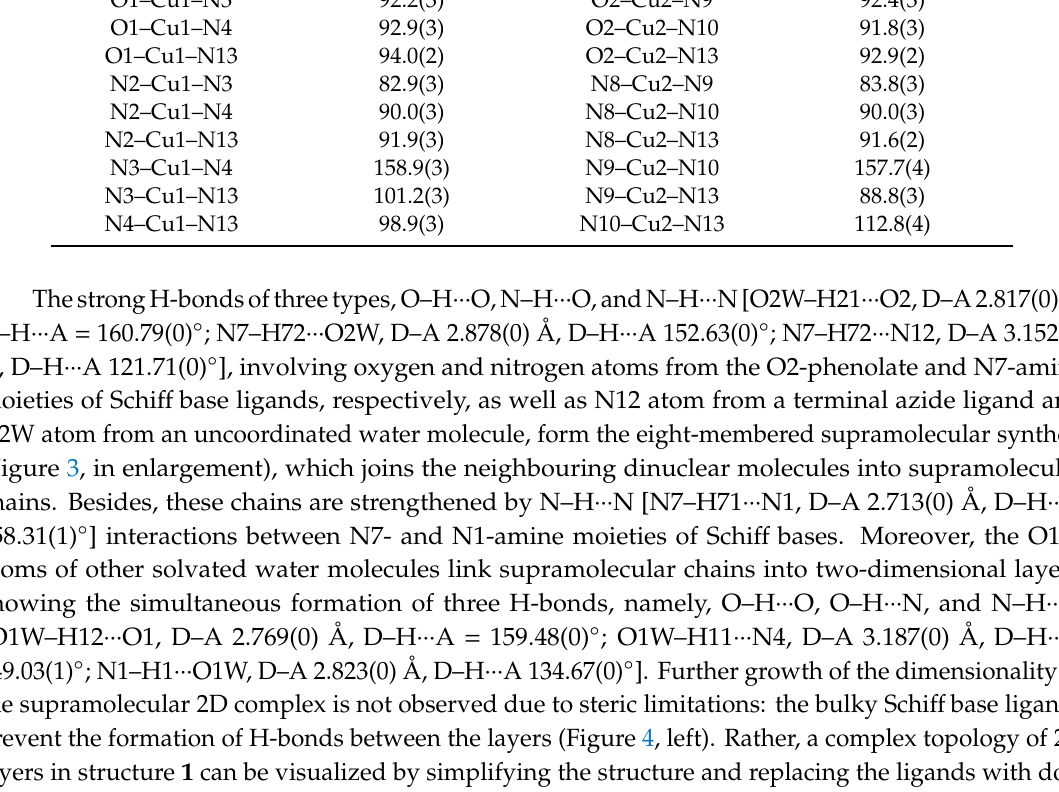
Figure 3. Representation of the supramolecular layer in 1 , viewed down the crystallographic b axis, with the enlarged fragment showing the supramolecular synthon formed by H-bonding between Schiff base ligands, terminal azide group, and uncoordinated water molecule. The hydrogen atoms are omitted for clarity. Colour scheme: Cu, cyan; O, red; N, blue; C, grey.